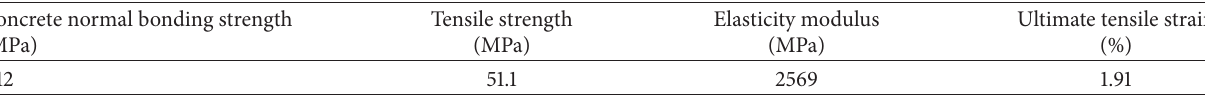
Table 3: Mechanics properties of